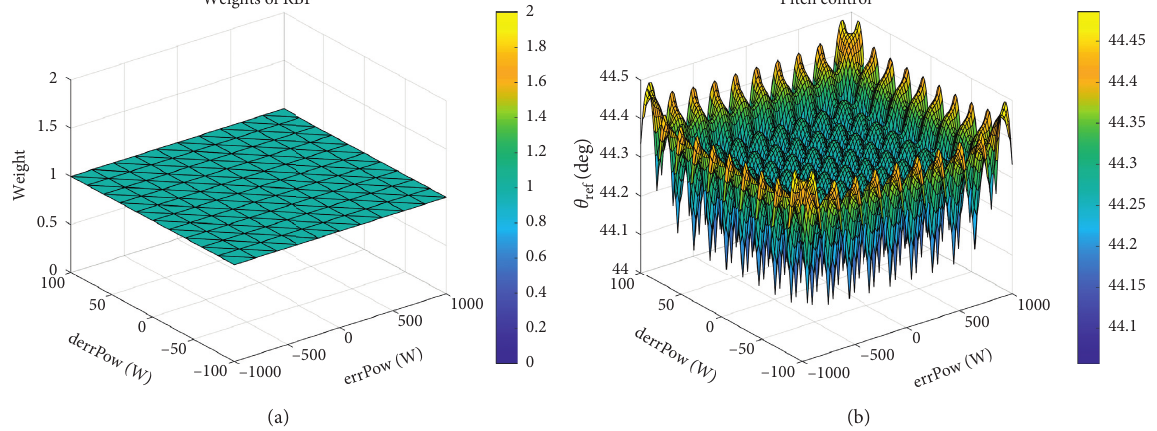
Figure 3: Weight surface (a) and pitch control law (b) before learning.